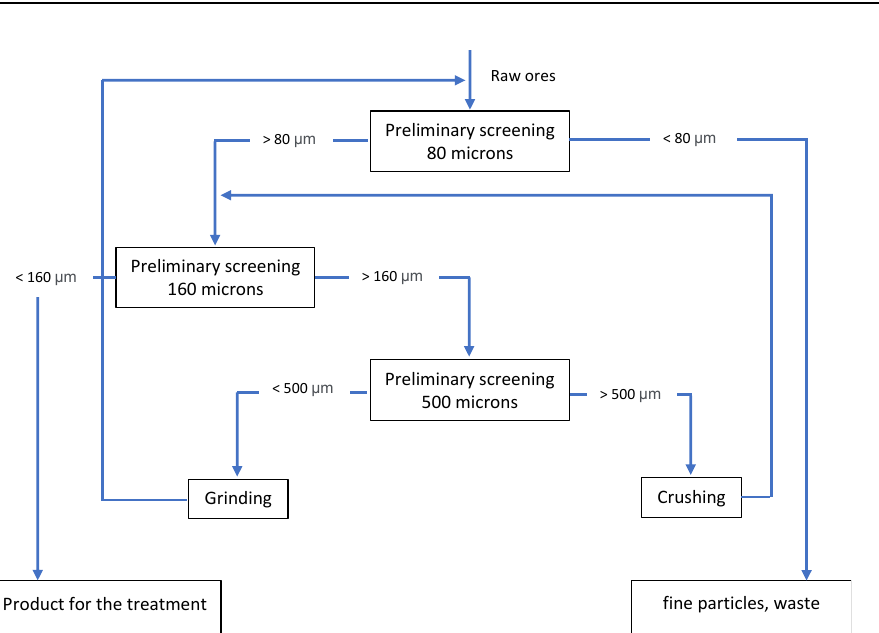
Figure Figure 1. Technological procedures (mechanical preparation) conducted for preparation of 80 – 160 μm fraction.